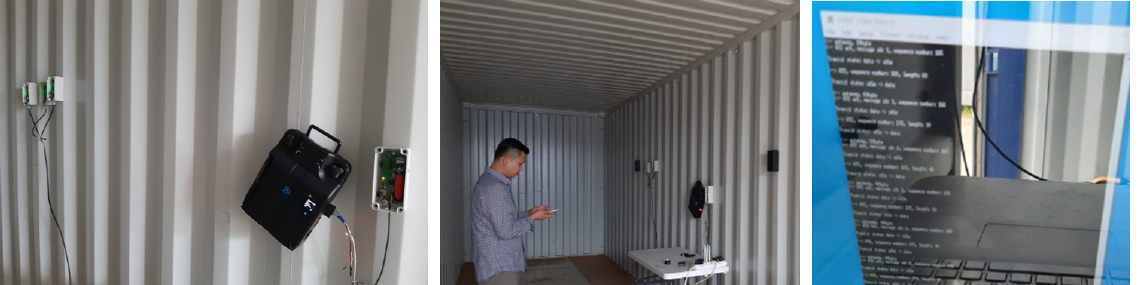
Figure 10. The ILMS system’s indoor test.